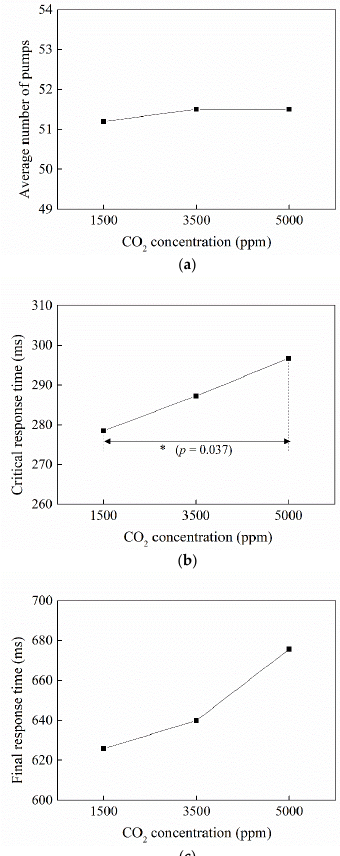
Figure 6. Performance metrics of the BART under different CO 2 conditions; * ( p < 0.05). ( a ) Average number of pumps on unexploded balloons. ( b ) Critical response time of pumps on unexploded balloons. ( c ) Final response time of pumps on unexploded balloons.